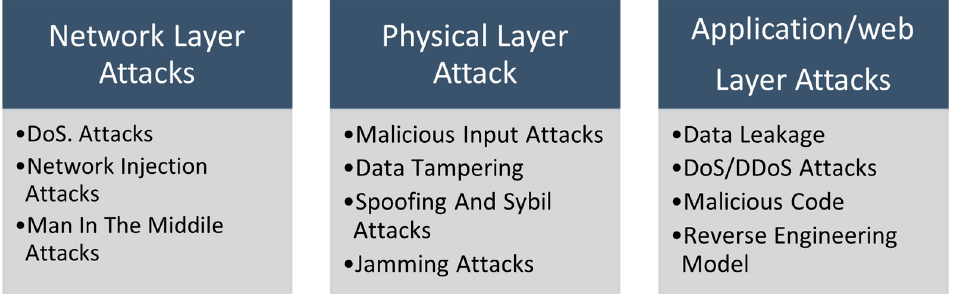
Figure 1. Cyberattack classification based on IoT layers.